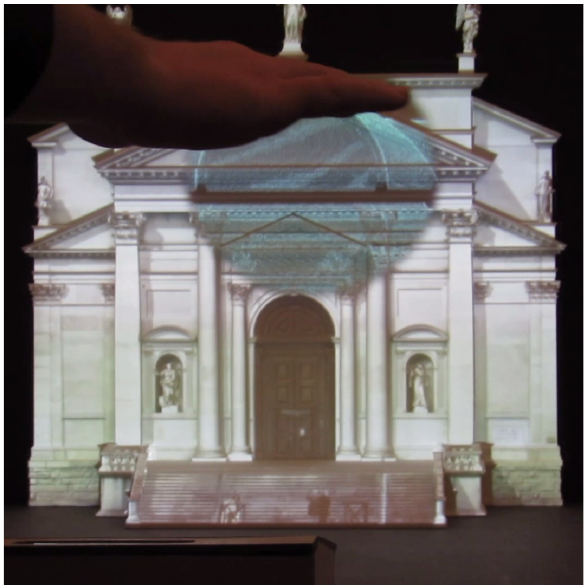
Figure 8. Hand control of the